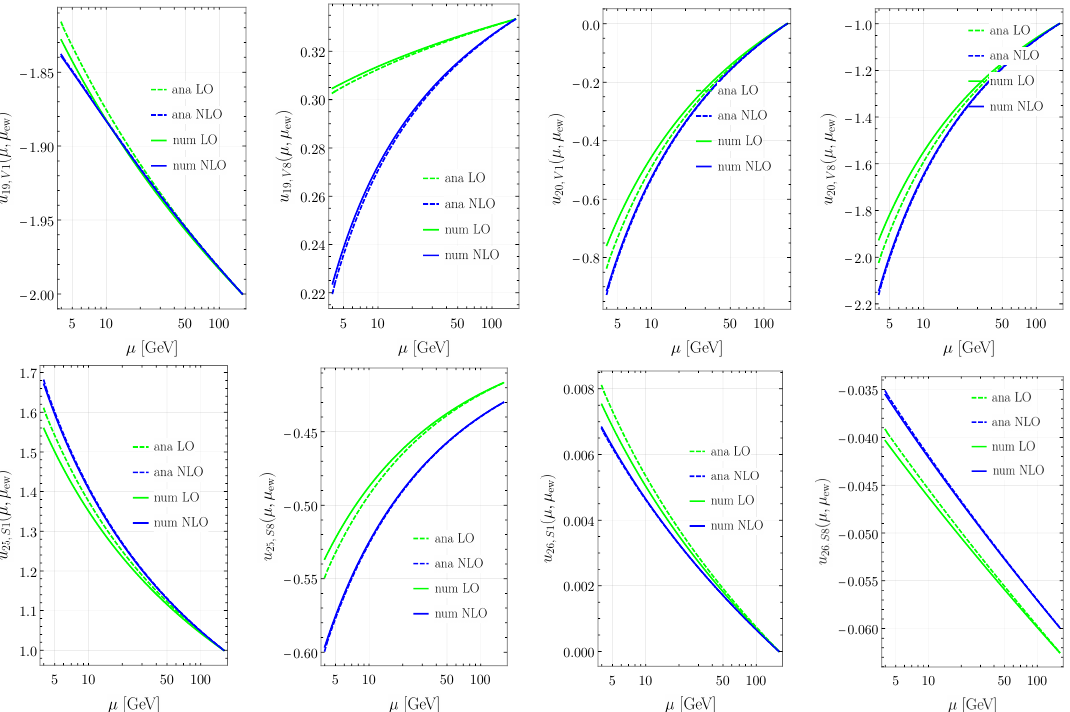
Figure 1 . The µ -dependence of the quantities u ab ( µ, µ ew ) at the LO [green] and NLO [blue] for the SRL , u [upper row] and the SRR , i [lower row] sub-sectors, in the N analytical solutions of the RG equations are shown with the solid and dashed lines,